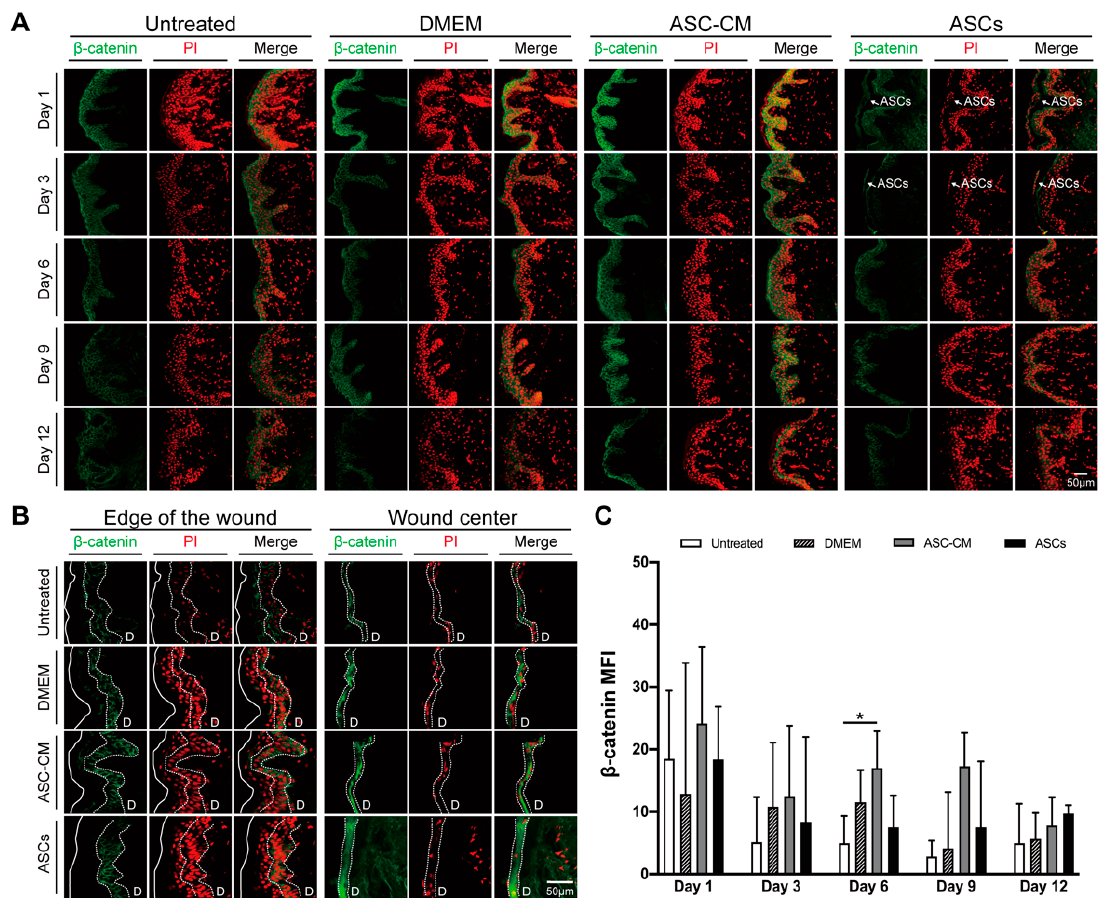
Figure 5. Time-dependent expression of β -catenin in the ex vivo wounds. ( A ) Immunofluorescence staining of β -catenin protein expressed in the epidermis close to the wound edges. Representative images of stained cryosections ( β -catenin in green, PI-stained cell nuclei in red, and overlay) for each group and time point. White arrow points to ASCs. All pictures were taken with the same magnification; scale bar, 20 µ m. ( B ) Representative immunostained sections of newly formed epithelia at the edge and in the center of wounds at day 12. The top of the wound is indicated with a continuous line while the newly formed epithelia is indicated by dashed lines. All pictures were taken with the same magnification; scale bar, 20 μ m. D, dermis ( C ) Analysis of the fluorescence intensity of at least 15 random fields per time point from three (control) or six donors (samples). The mean fluorescence intensity (MFI) was measured using the ImageJ software. Data are shown as median with interquartile range (IQR). The statistical analysis was performed using the Mann–Whitney U test. * p < 0.05.